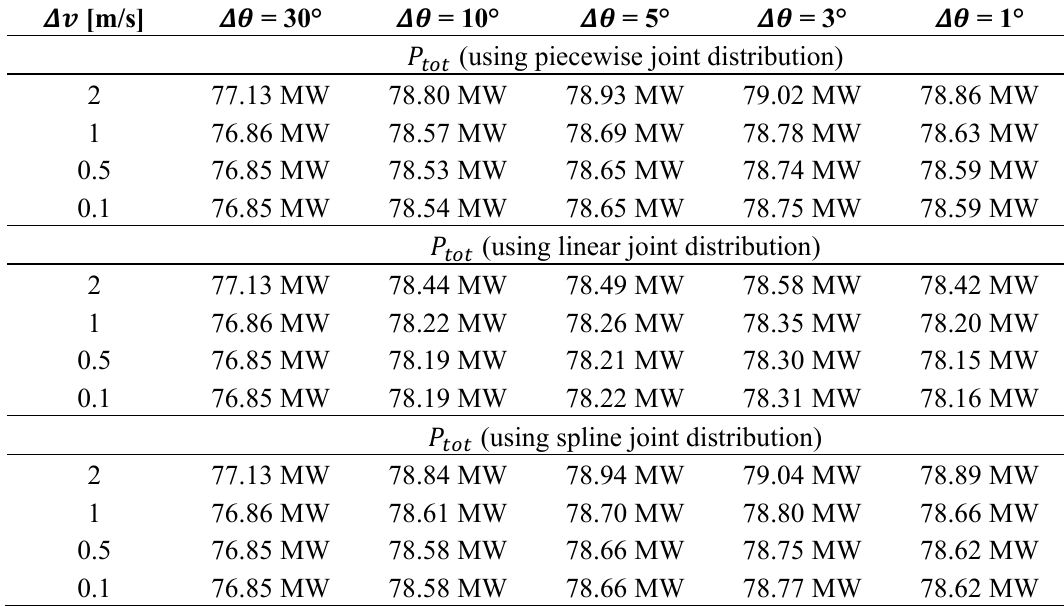
Table 2. Sensitivity of power calculation to bin sizes when using different joint